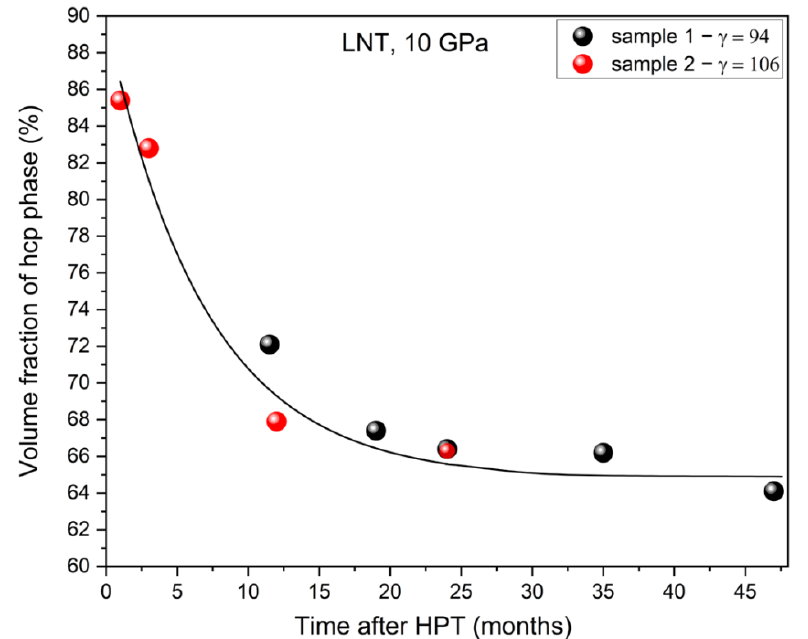
Figure 11. Reverse phase transformation of hcp to fcc during storage at ambient conditions inves- tigated for two samples HPT-deformed at LNT.